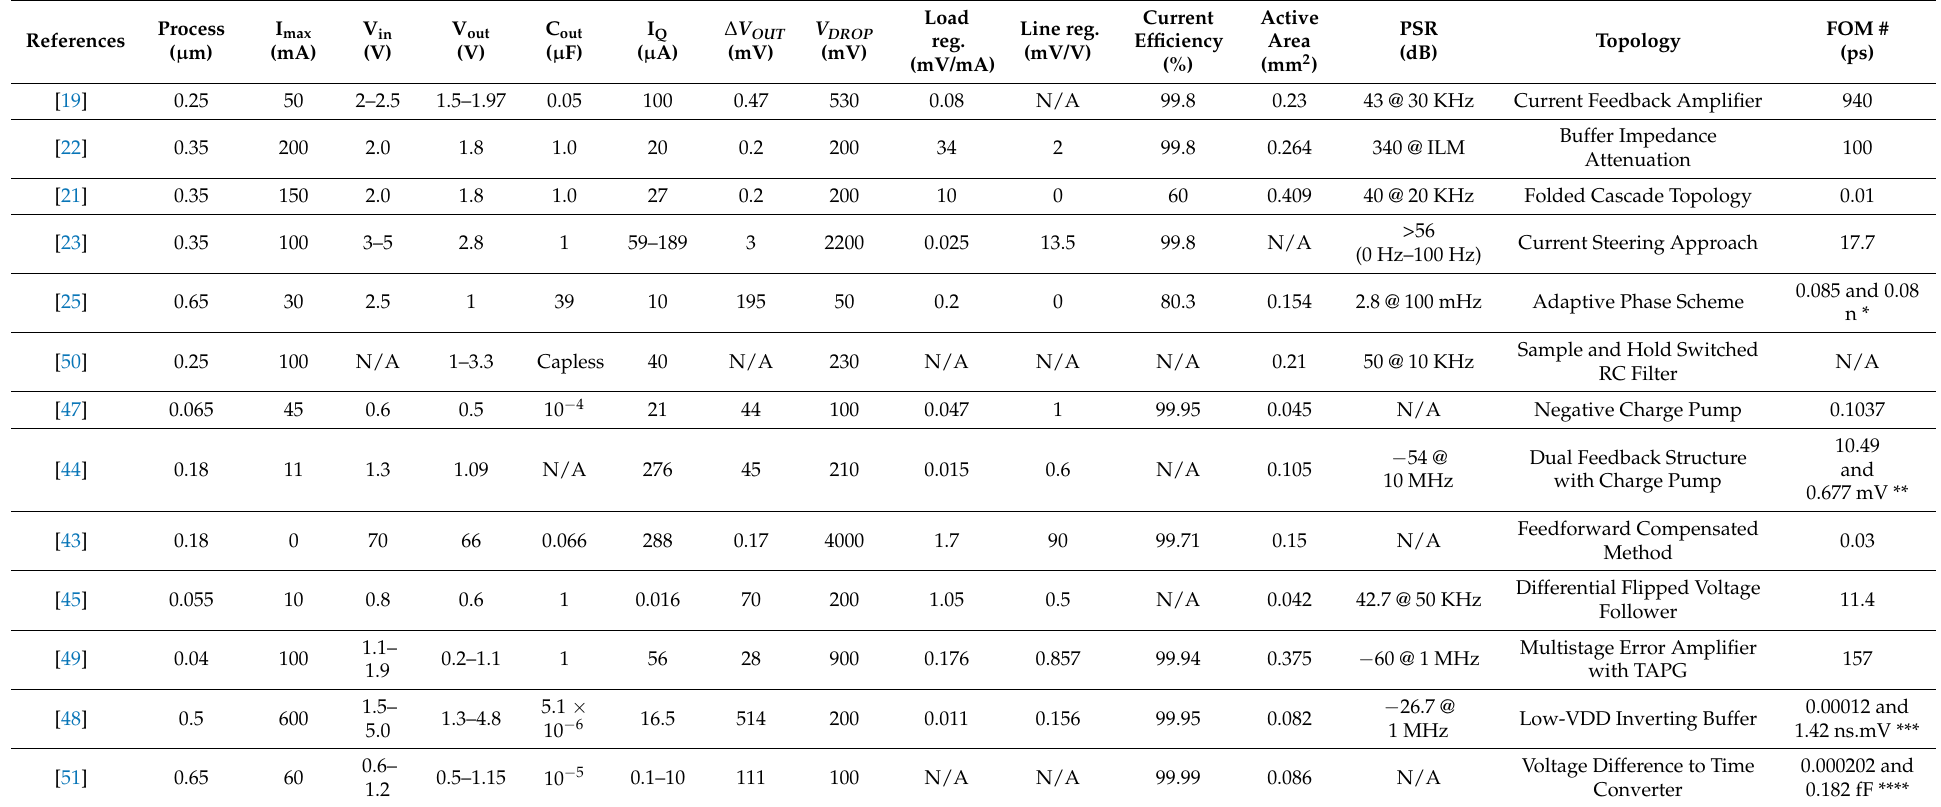
Table 1. Summary of the ALDO performance